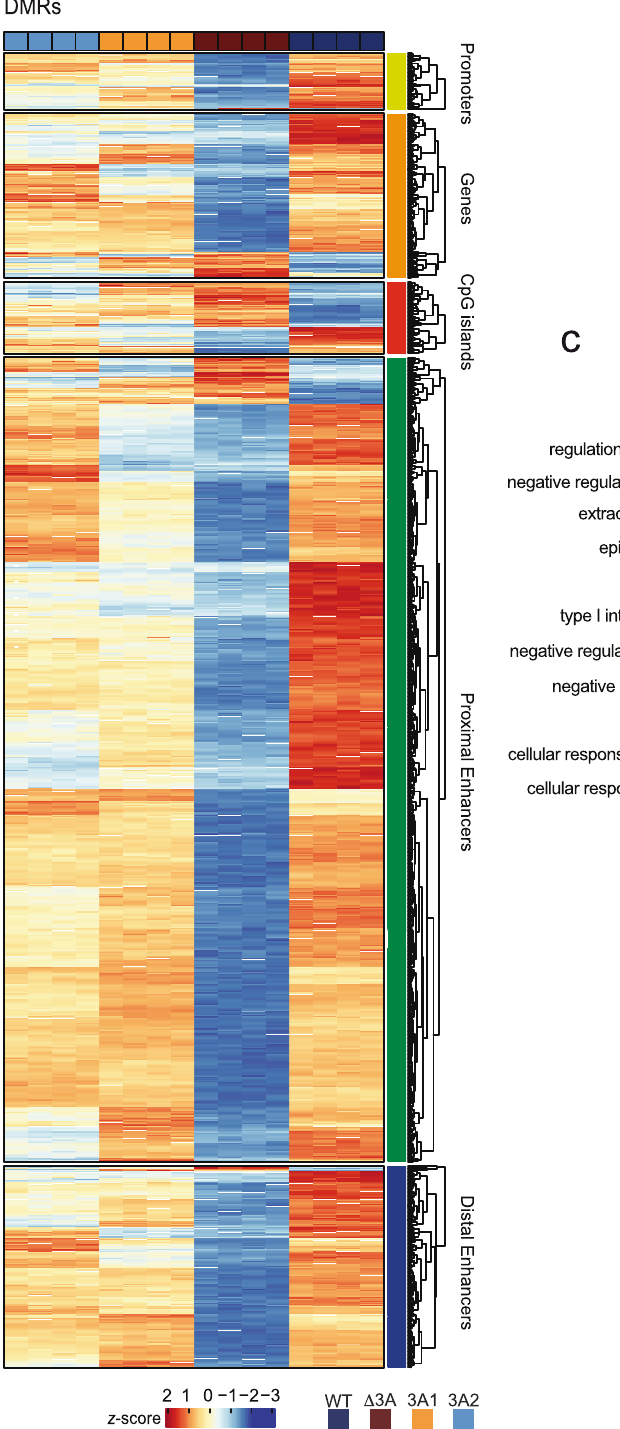
Fig.3|DNAmethylationchangesinDNMT3A-depletedCaco-2cells.a Heatmaps of differentially methylated regions (DMRs) of WT, Δ DNMT3A, DNMT3A1, and DNMT3A2celllines( n =4).Scaledgeneexpression/methylationintensityacrossall samples are plotted. b Bar plot indicating number of regions differentially methylated in genes rescued by DNMT3A1 and DNMT3A2 isoforms. c Correlation